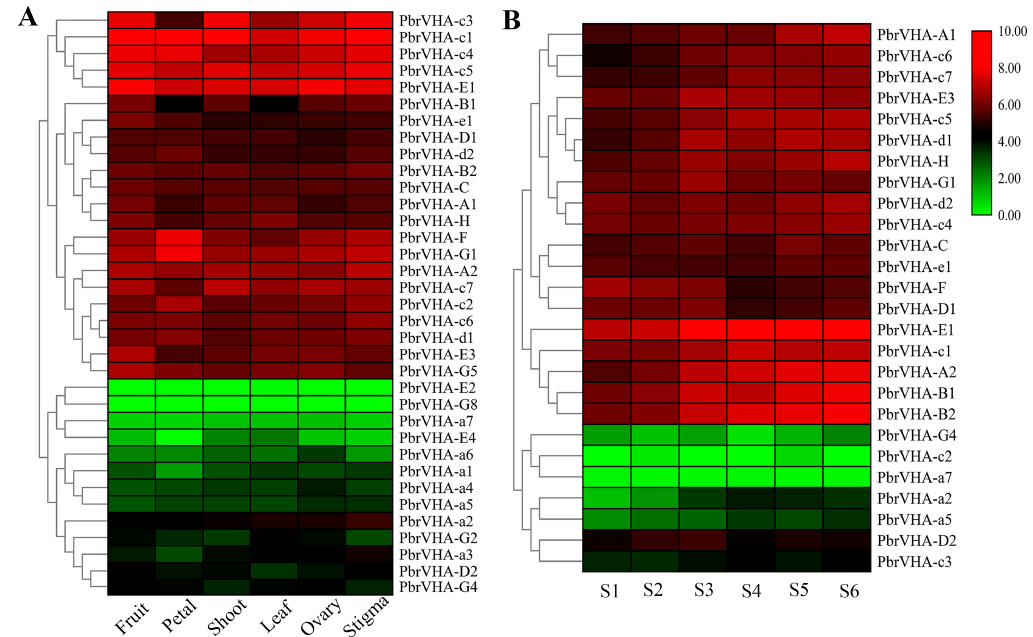
Figure 5. Expression patterns of PbrVHA genes in different tissues and during fruit development of “Yali” pear. ( A ) Expression patterns of PbrVHA genes in six different tissues, including fruit, petal, shoot, leaf, ovary, and stigma. ( B ) Expression profiles of PbrVHA genes during fruit development, including the fruit-setting stage (S1), physiological fruit dropping stage (S2), fruit rapid enlargement stage (S3), a month after fruit enlargement stage (S4), pre-mature stage (S5), and mature stage (S6). The expression levels were calculated as log2-transformed (RPKM + 1) values. Green, black, and red indicate low, moderate, and high levels, respectively.